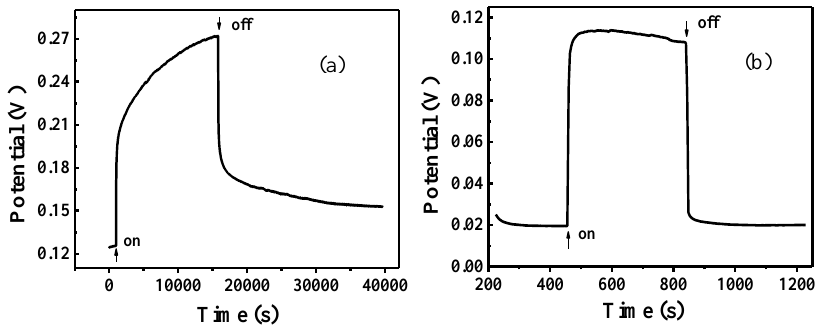
Figure 5. Photovoltage measured as a function of time for FTO/TiO FTO/Cu O (b) electrodes 2